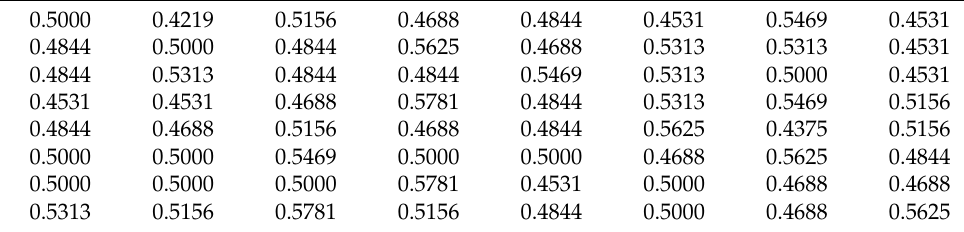
Table 6. Dependency matrix for avalanche effect.